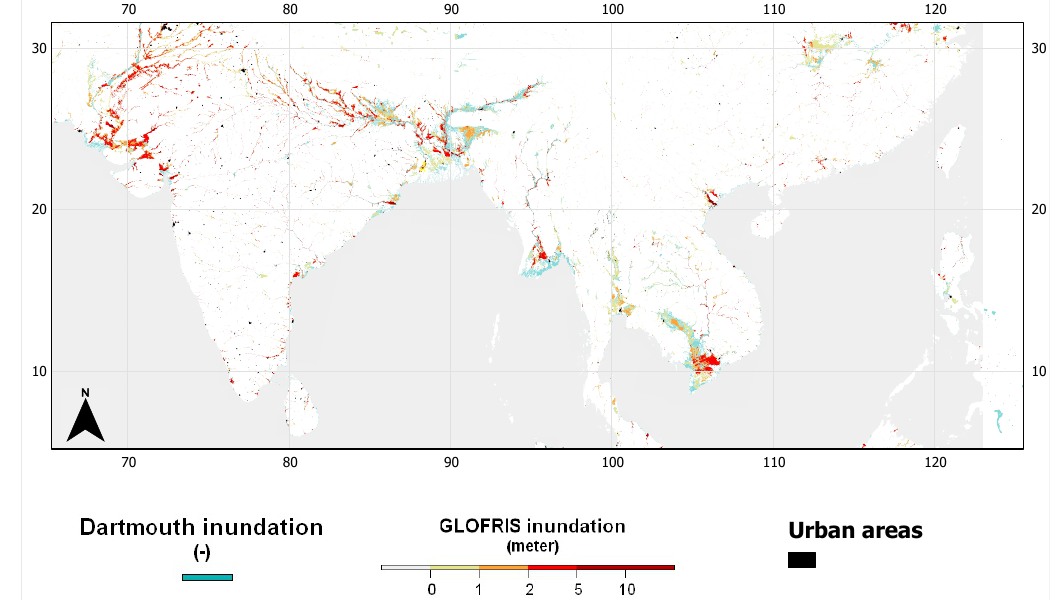
Fig. 4. Once-in-30yr inundation according to GLOFRIS model cascade, overlaid on the Dartmouth Flood Observatory maximum inundation